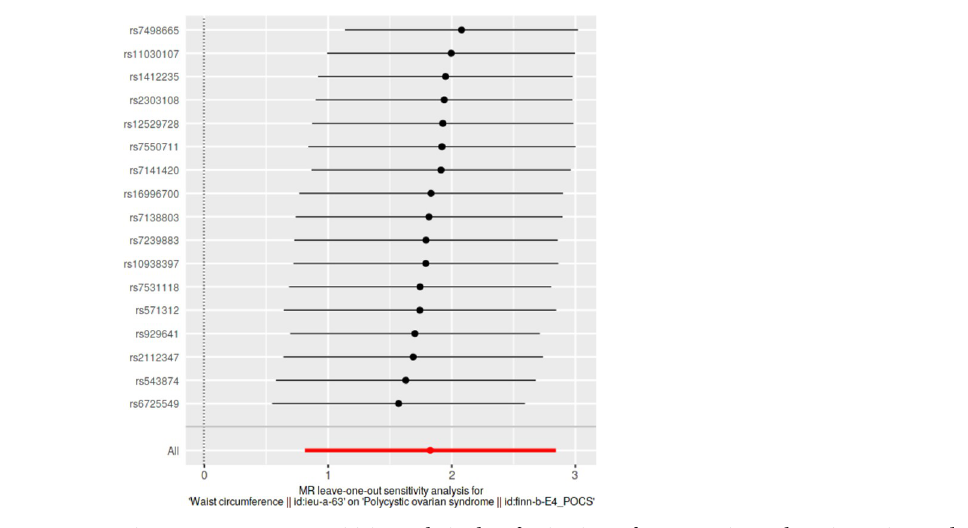
Fig 11. Leave-one-out sensitivity analysis plot of waist circumference, against polycystic ovarian syndrome as the outcome. A given dark point indicates the effect measure from inverse variance weighted Mendelian randomization analysis excluding that specific SNP. The red lines indicate pooled analyses encompassing all SNPs via IVW-MR method (drawn for comparison).